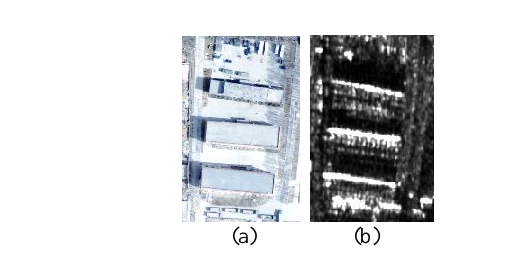
Figure 3. Airborne SAR image in Yushu City acquired (by NASG, China) on April 17, 2010, immediately after Ms7.1 earthquake occurred in Yushu, Qinghai, China on April 14. The image has been pre-processed with spatial registration and speckle denoising filtering.